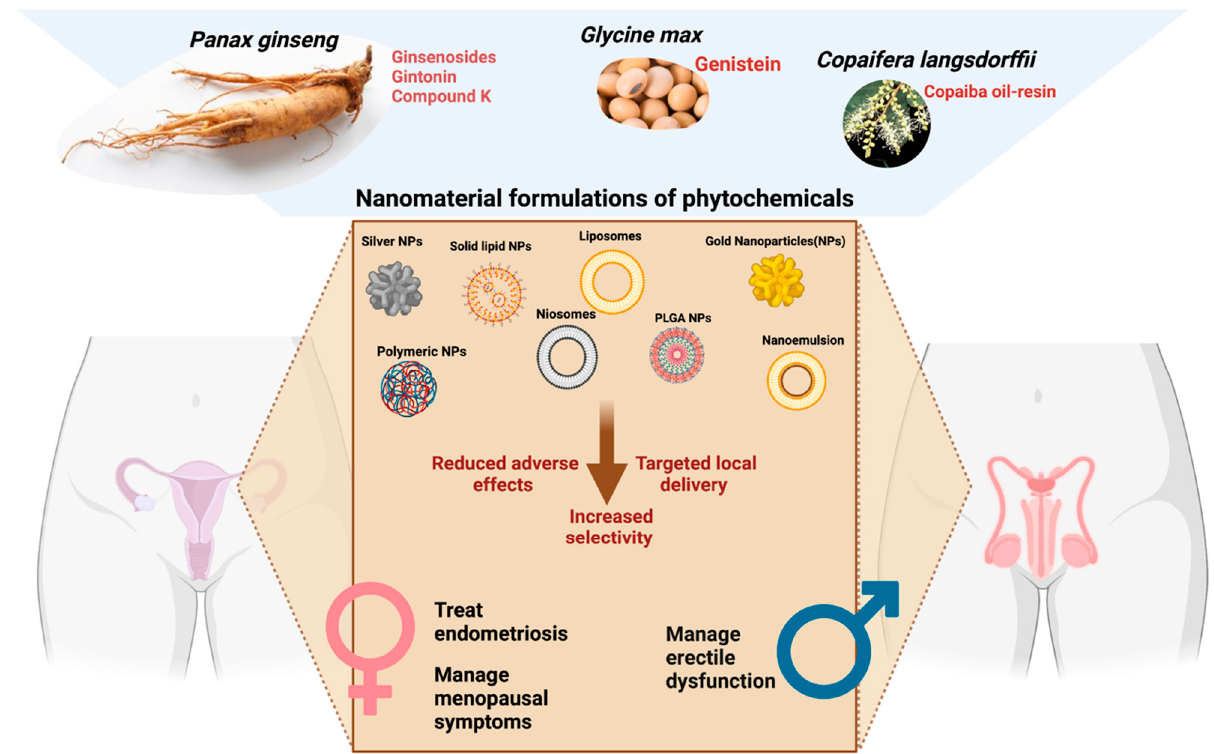
Figure 3. Application of nano-phytopharmaceuticals in urogenital disorders. The figure was made with www.biorender.com (access date: 15 March 2022).